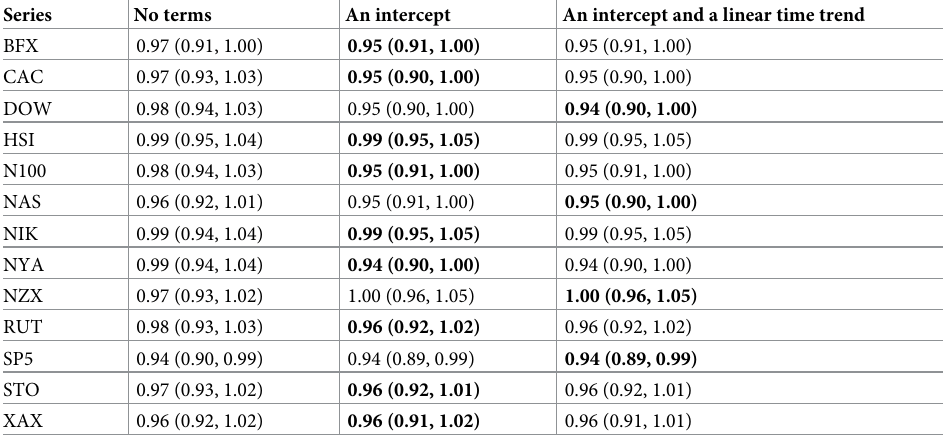
Table 1. Estimates of d for the GOLD differential. Sample ending in Dec.